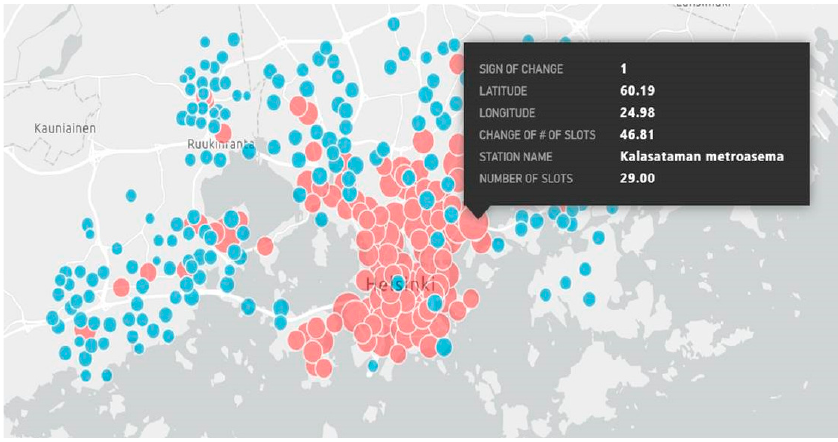
Figure 3. The information that is connected to each circle in the calculation